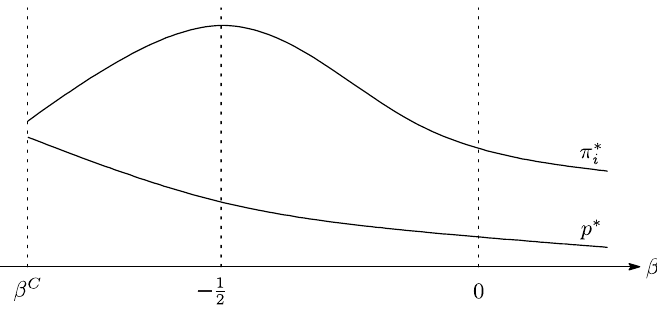
Fig. 1. Competition properties of equilibrium price and profits in the cartel